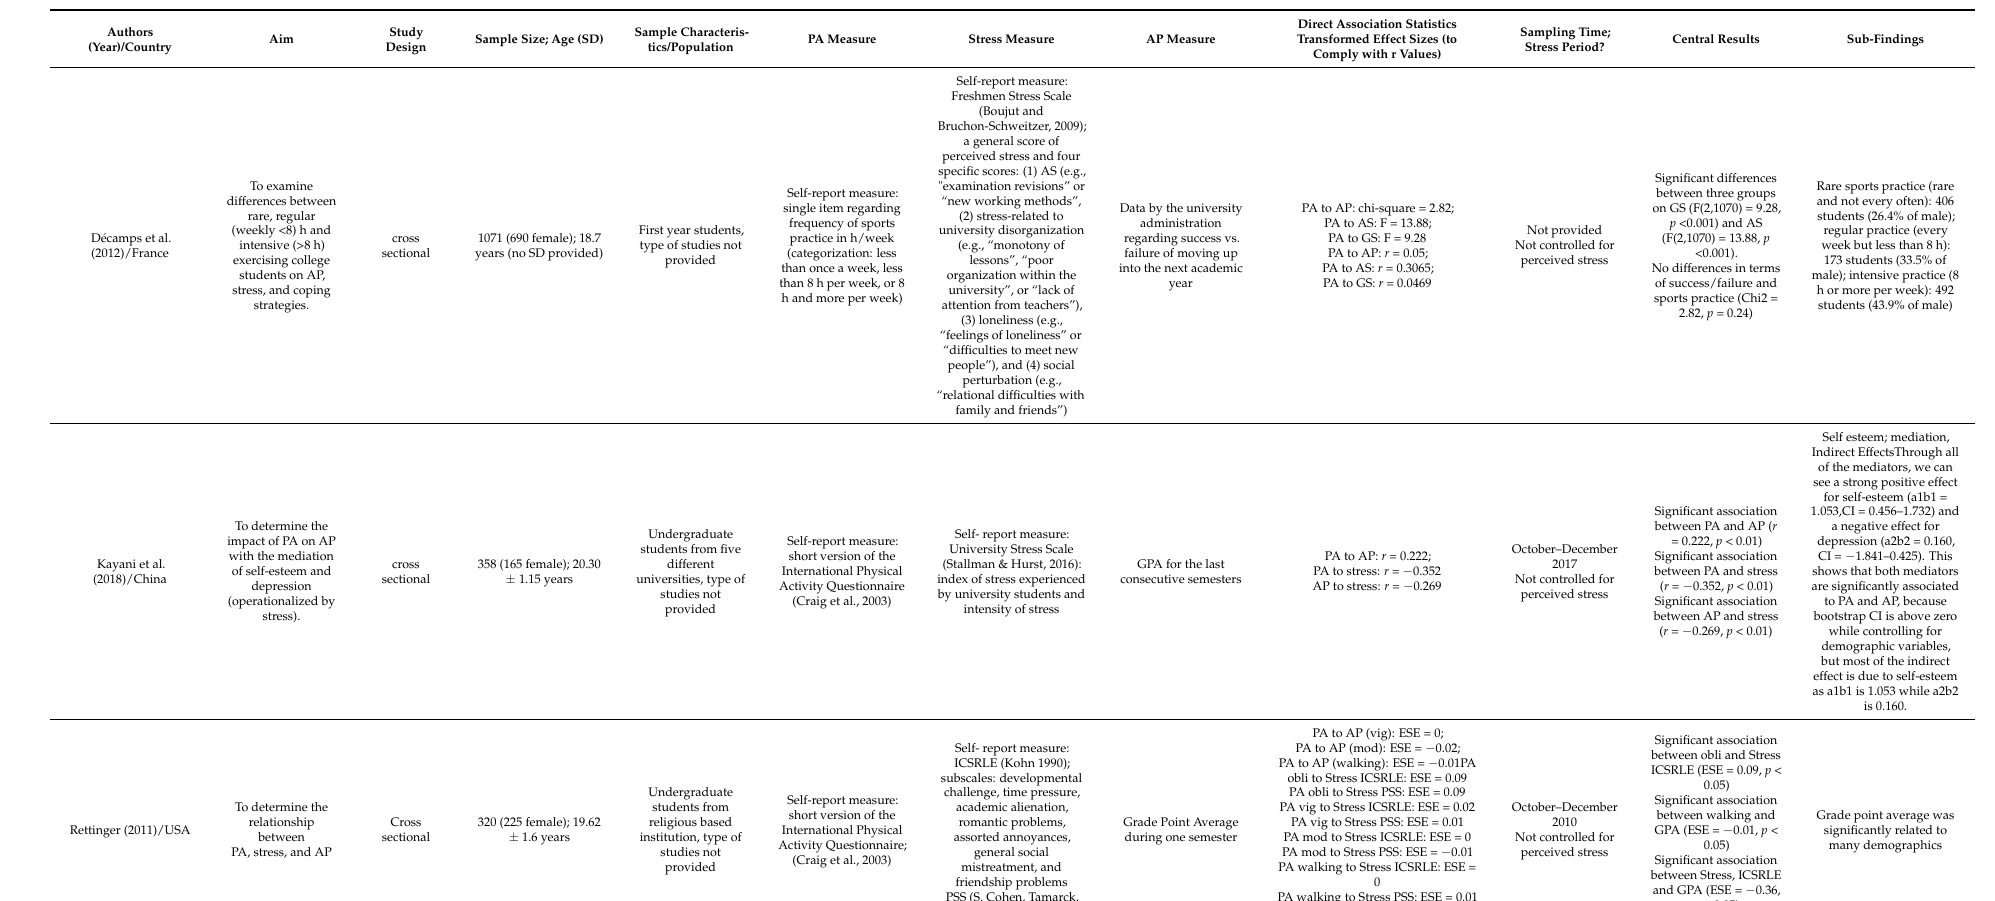
Table 1. Study characteristics of included